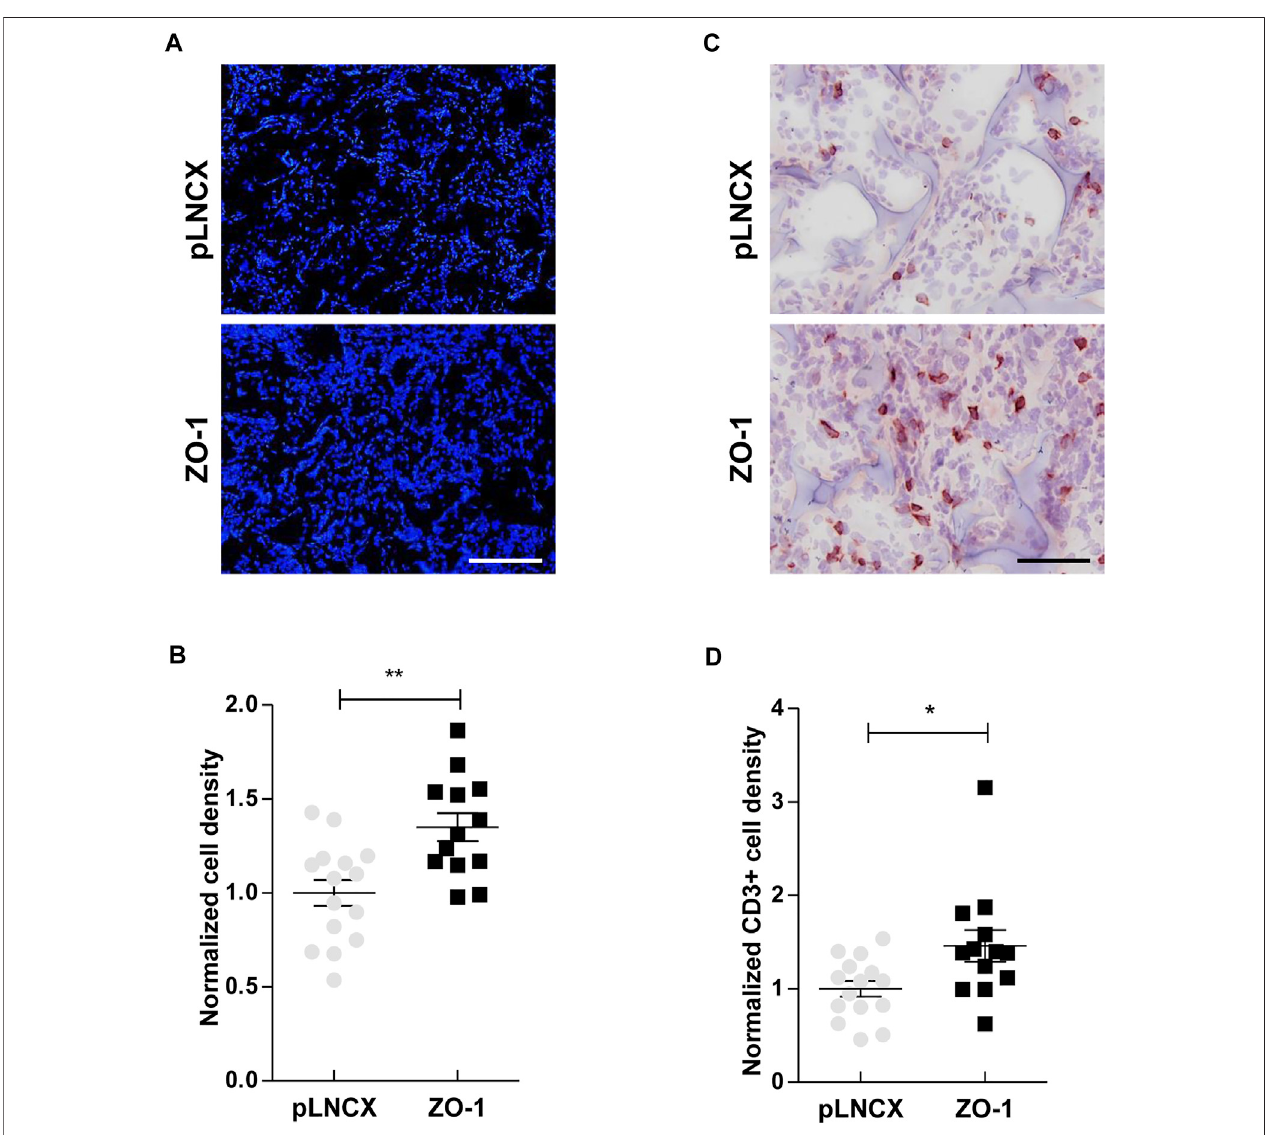
FIGURE 2 | ZO-1 promotes an immune response in vivo . (A) DAPI staining on ear sections containing 21-days sponges soaked in conditioned medium of BEAS- 2BcellstransfectedwithZO-1expressionvector(ZO-1)orthecorrespondingpLNCXcontrolvector(pLNCX).Scalebar (cid:2) 120 µm. (B) Celldensityanalysisperformingby quanti fi cation of DAPI staining. (C) CD3 immunostaining on ear sections containing 21-days sponges soaked beforehand in conditioned medium of BEAS-2B cells transfected with ZO-1 cDNA or pLNCX empty vector. Scale bar (cid:2) 80 µm. (D) T lymphocyte density analysis following quanti fi cation of CD3 labeling. Data are expressed as fold induction relative to the respective control conditions in three independent experiments. Means ± SEM; n (cid:2) 15; *p < 0.05, **p < 0.01.